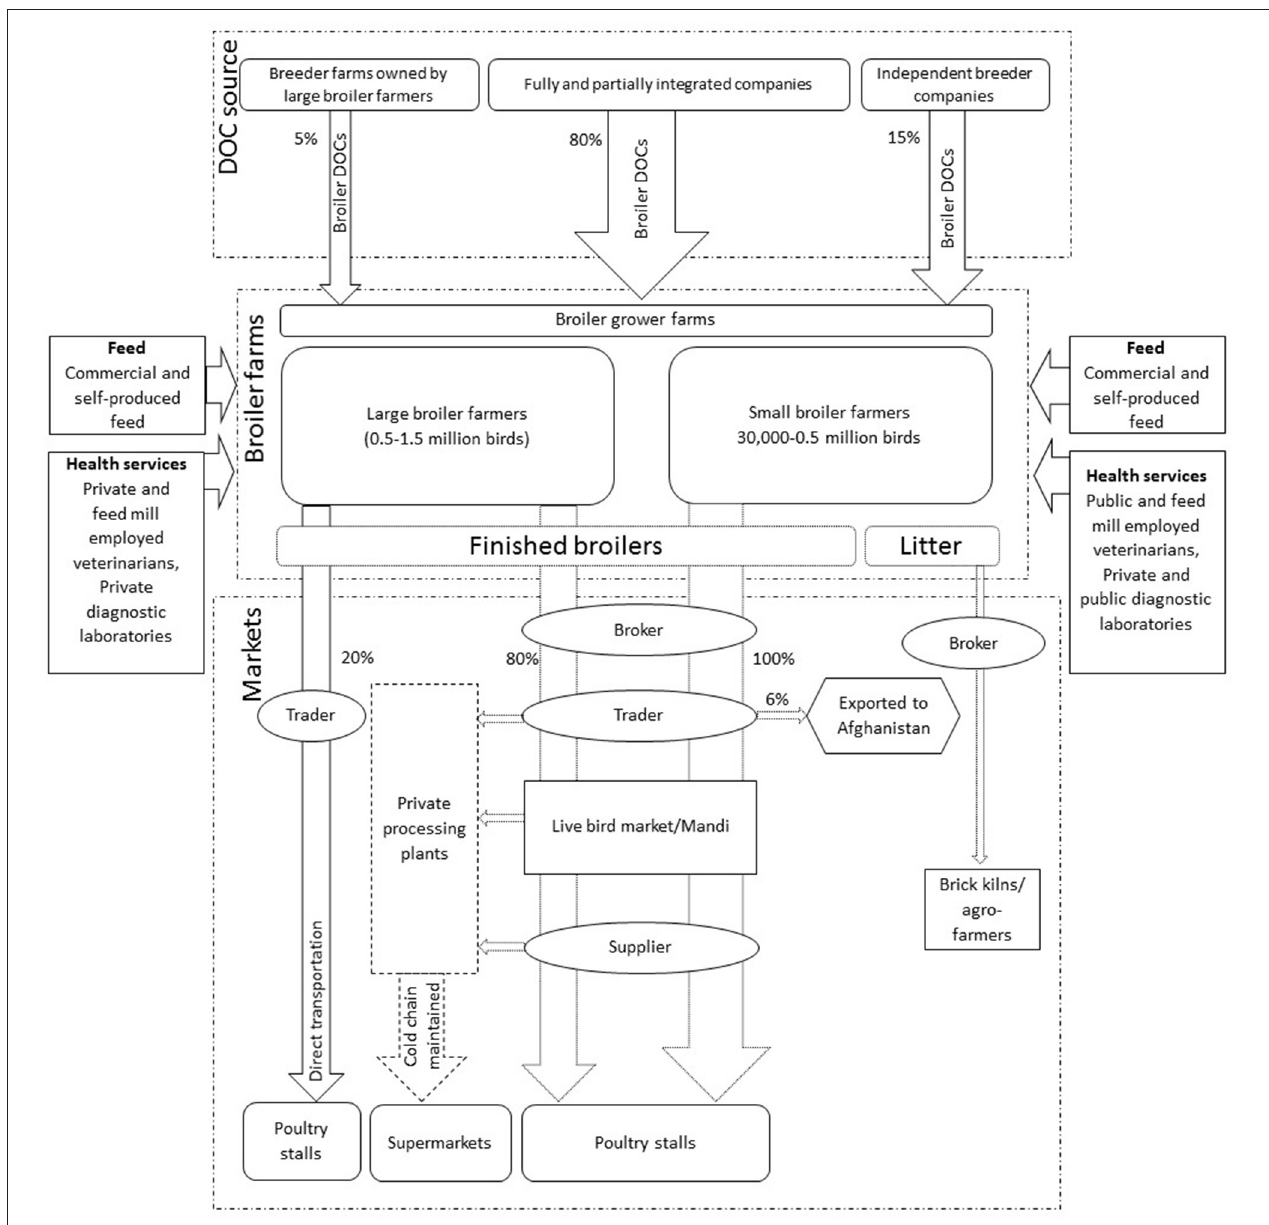
FIGURE 5 | Map of independent broiler farming, its types, distribution chains, and target markets. DOC indicates day old chicks, Mandi in local language Urdu is a wholesale live bird market where birds are sold by open auction. Dotted lines show the parts of chains operated by the middlemen. Numbers in and around arrows and width of arrows indicate the market